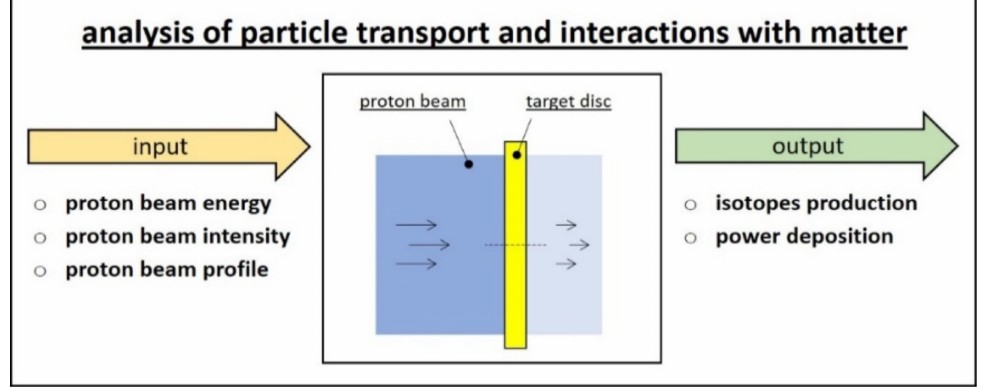
Figure 2. Schematic representation of the analysis of particle transport and interactions with